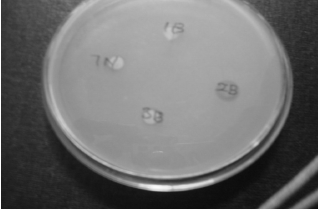
Figure 8. Cu(II) & Co(II) complex inhibition zone of